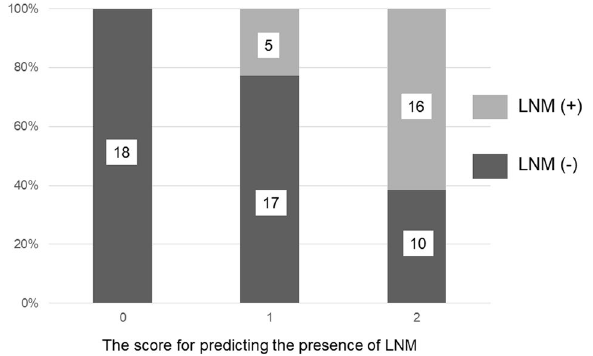
Figure 2. The relationship between the score for predicting the presence of LNM and the rate of actual LNM. The incidence of LNM significantly increased as the score increased ( P <